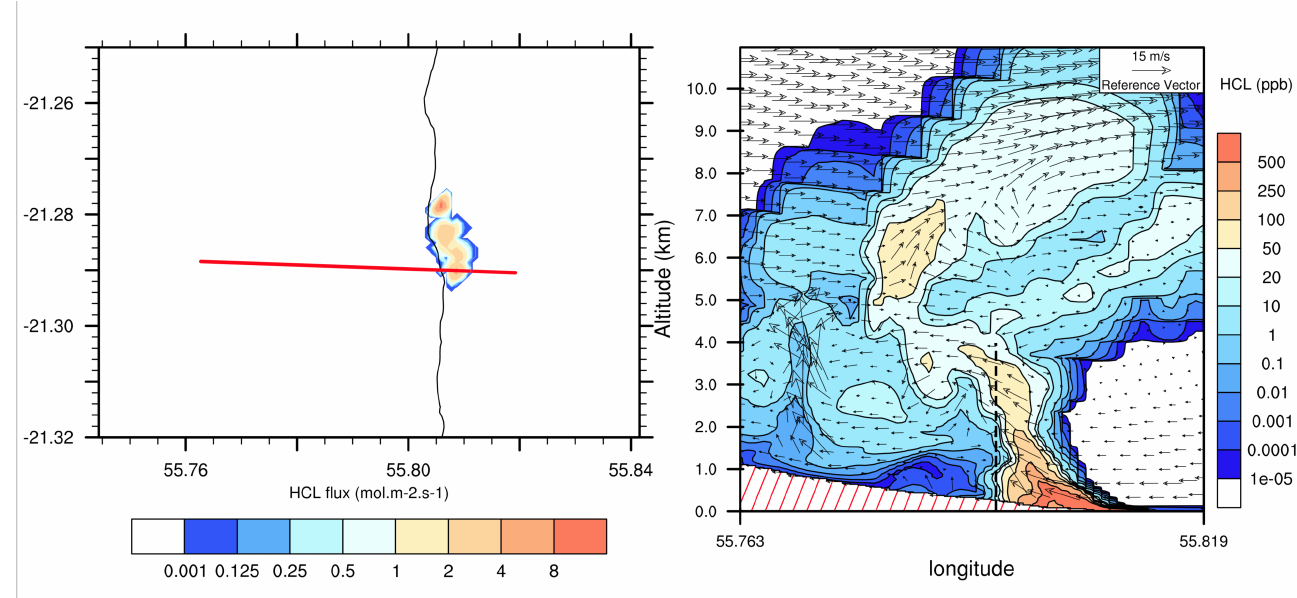
Figure 11. ( left ) HCl Fluxes (in mol · m 2 · s − 1 ) due to the entry of lava into the sea simulated by MesoNH on 6 April at 06:00UTC. Axis of the vertical section in red. ( right ) Vertical section representing the concentration of HCl (ppb) and the projected wind vectors in the axis of the section. Dashed line corresponds to the cross section of Figure